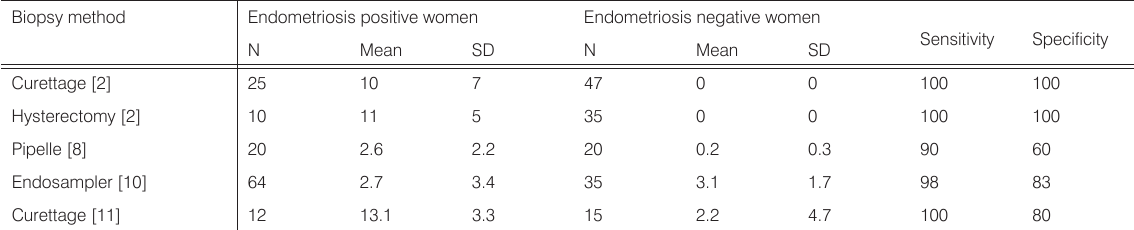
Table 1. Nerve fibre density per mm² in the functional layer of endometrial biopsy Biopsy method